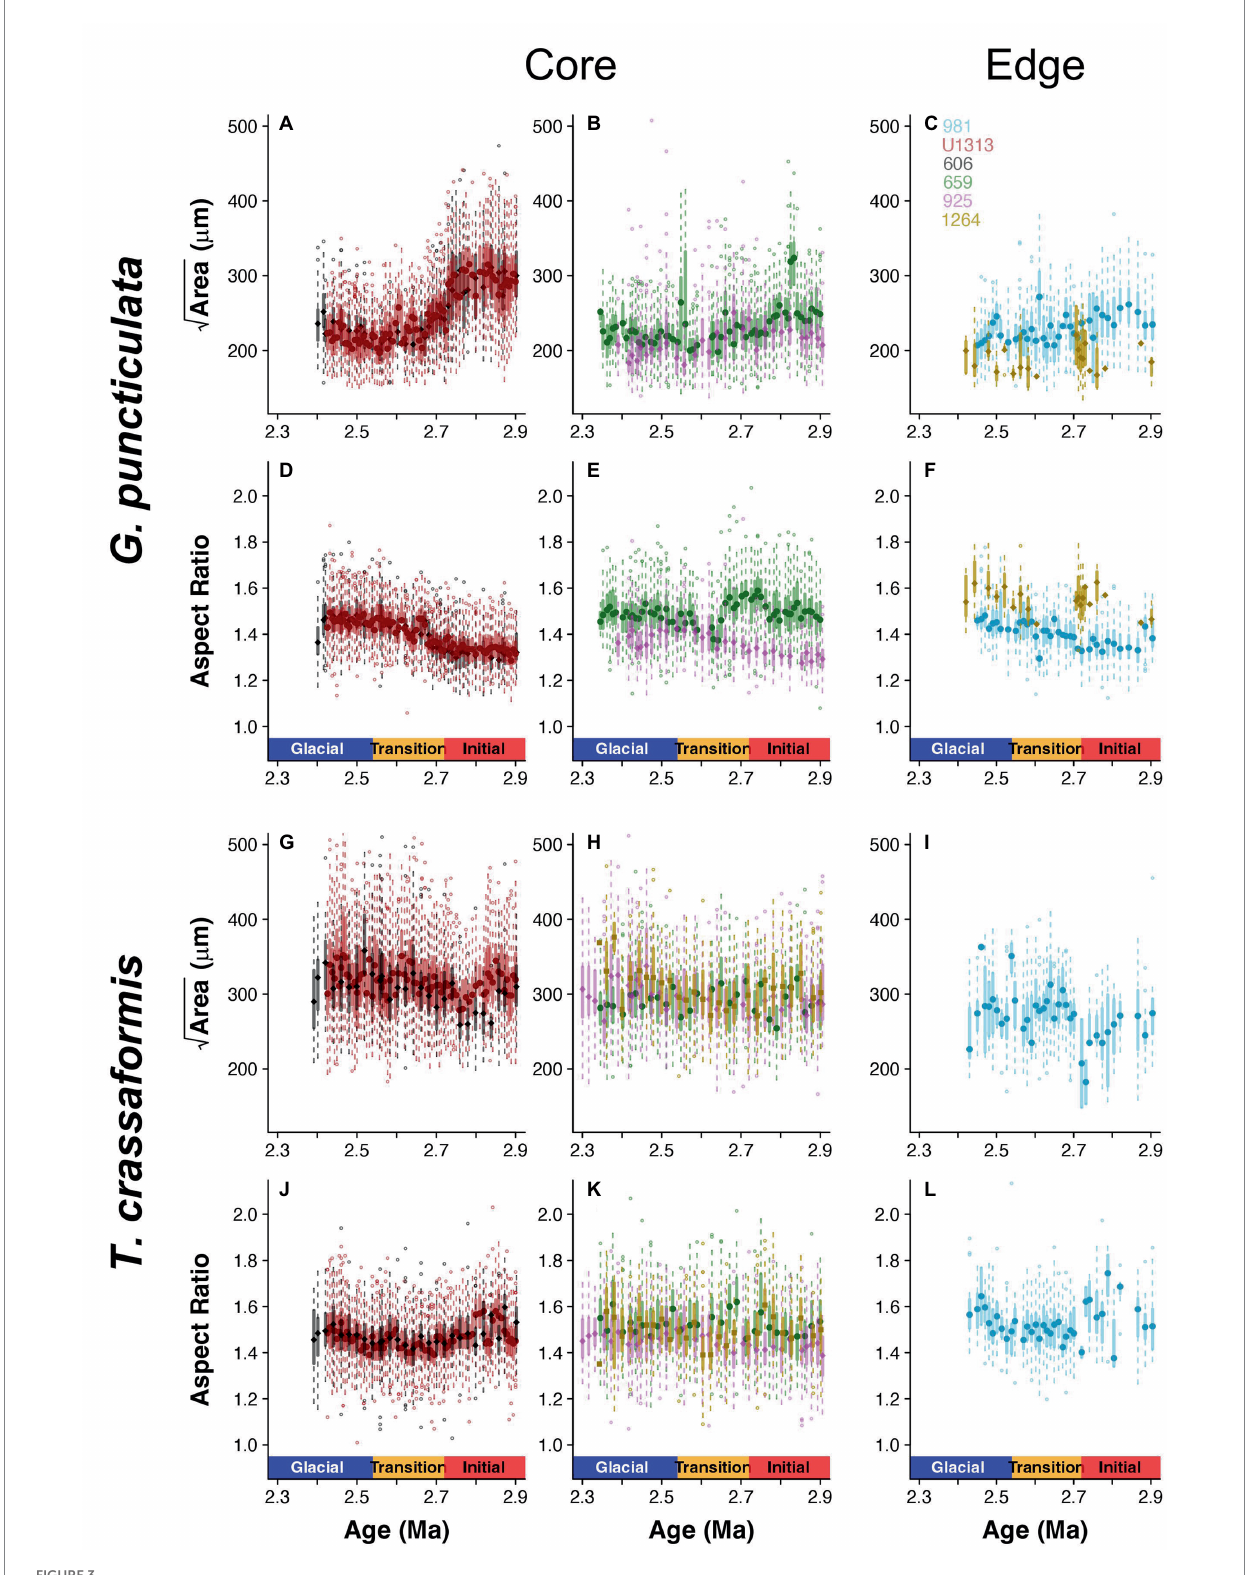
FIGURE 3 Box-and-whisker plots of size (Area) and shape (Aspect Ratio) data for Globoconella puncticulata (A–F) and Truncorotalia crassaformis (G–L) per time slice across the three climate phases at each of the six study sites, divided into core (left and middle column) and edge populations (right